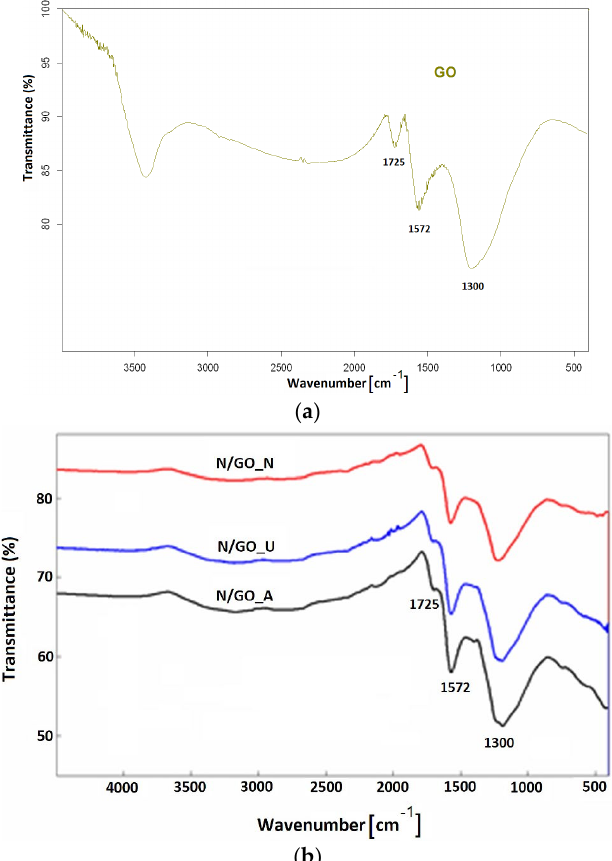
Figure 2. FT − IR spectra of: ( a ) GO and ( b ) Nitrogen-doped graphene oxide materials prepared by using different nitrogen precursors: N/GO_A from ammonia; N/GO_U from urea, and N/GO_N from nitric acid.